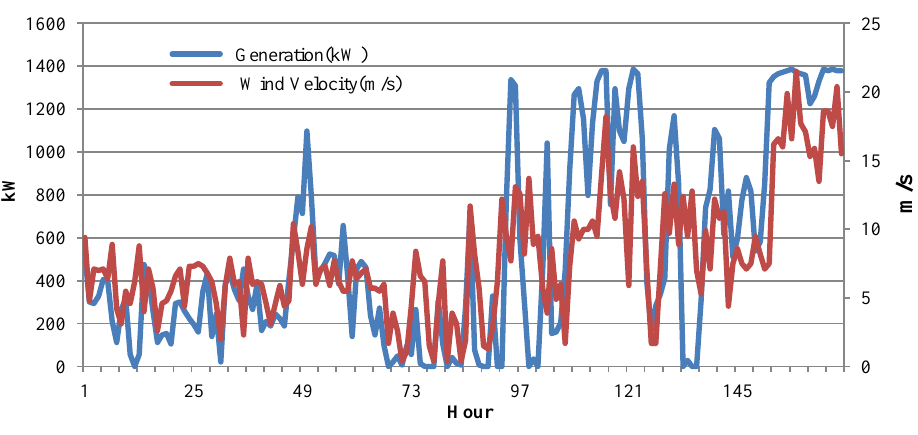
Figure 3. Average power output and wind speed per hour.